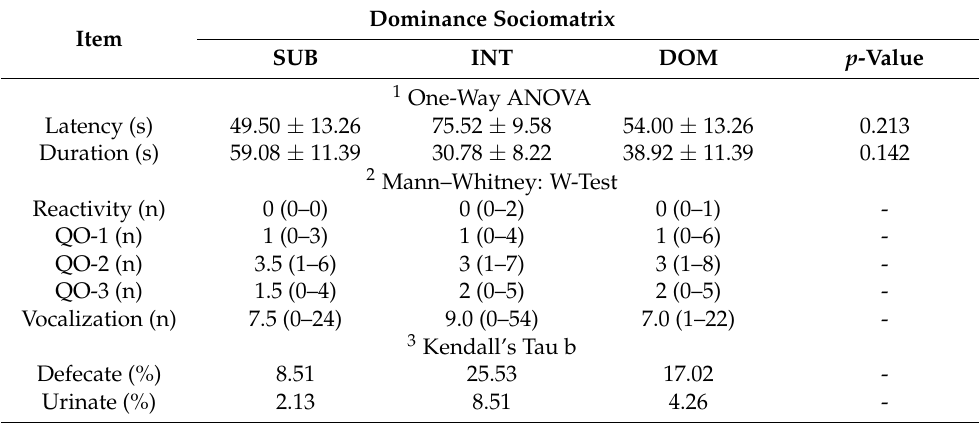
Table 7. Data from novel object test according to the dominance sociomatrix of finishing